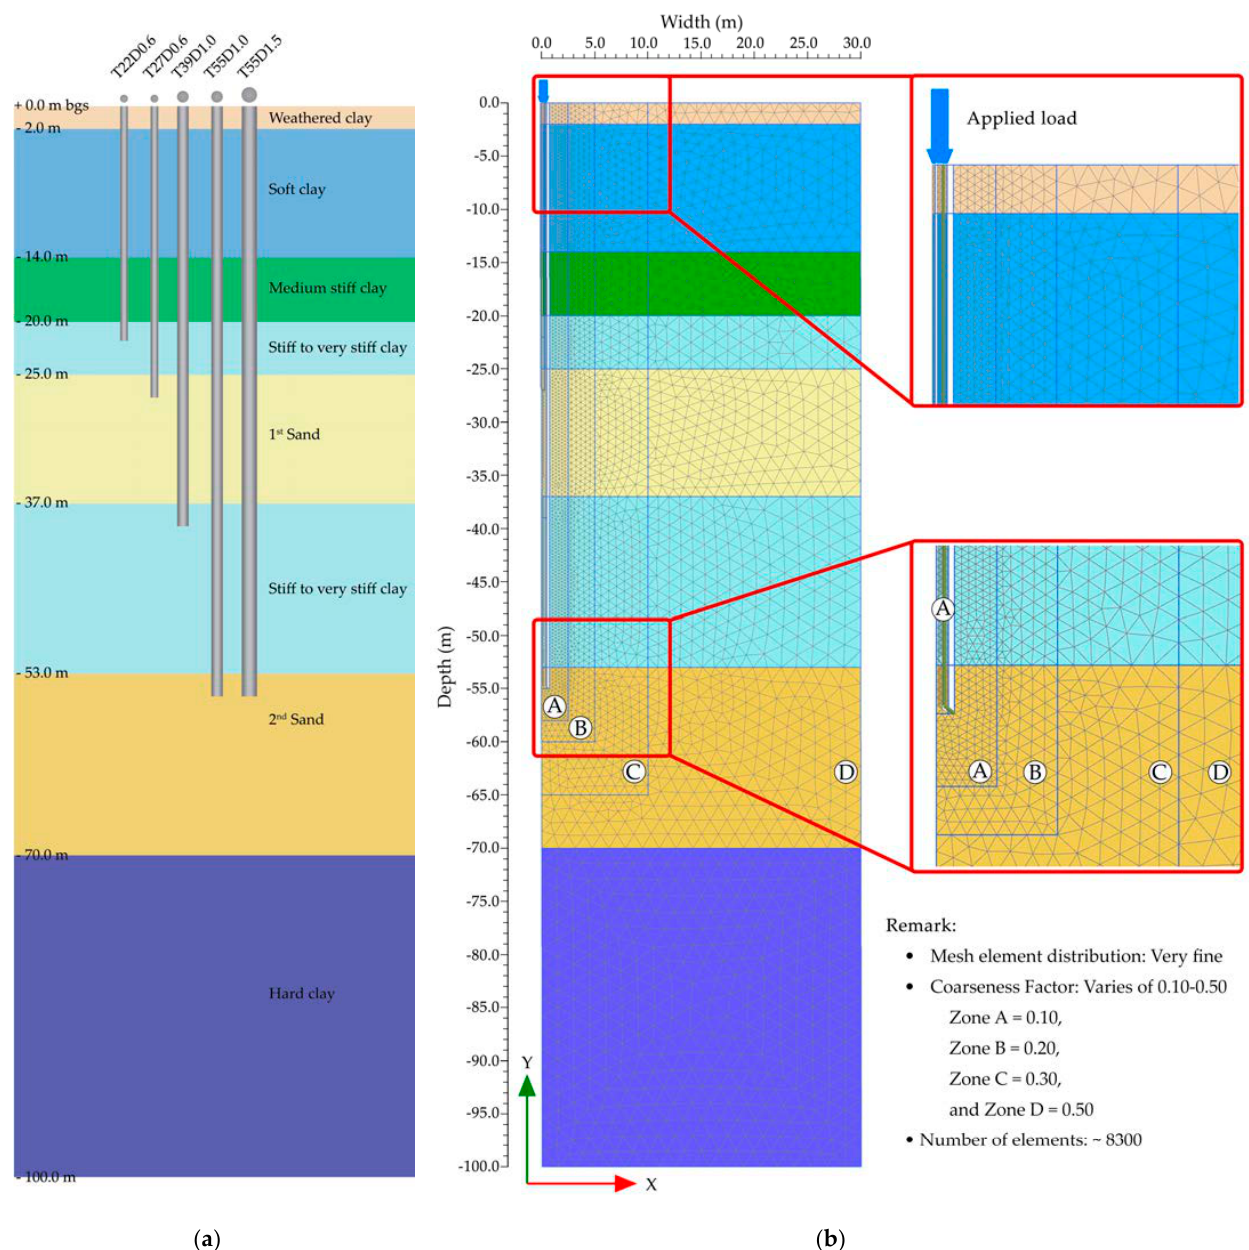
Figure 3. Model and mesh used: ( a ) Pile dimensions and soil layers; ( b ) finite element mesh.